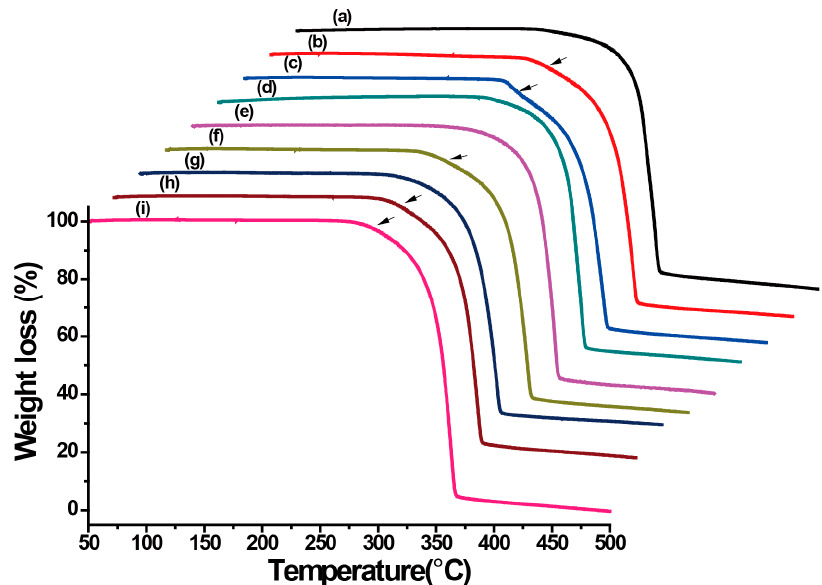
Figure 6. Thermogravimetry (TG) curves of LLM-105 crystals obtained from different antisolvents. ( a ) Water, ( b ) methanol, ( c ) acetic acid, ( d ) nitromethane, ( e ) ethyl acetate, ( f ) ethanol, ( g ) methylene chloride, ( h ) o-dichlorobenzene, and ( i ) toluene. Table 1. Thermal analysis of LLM-105 crystals obtained from different antisolvents.